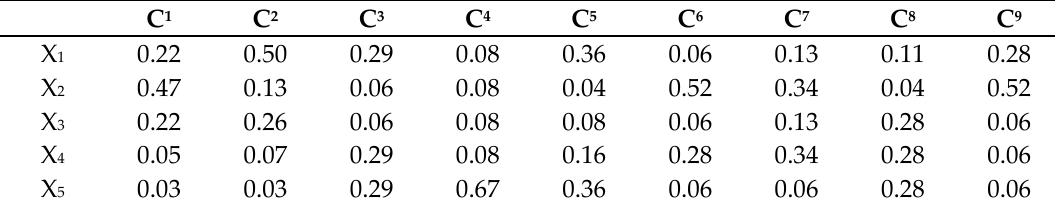
Table 7. Decision matrix after AHP evaluation.